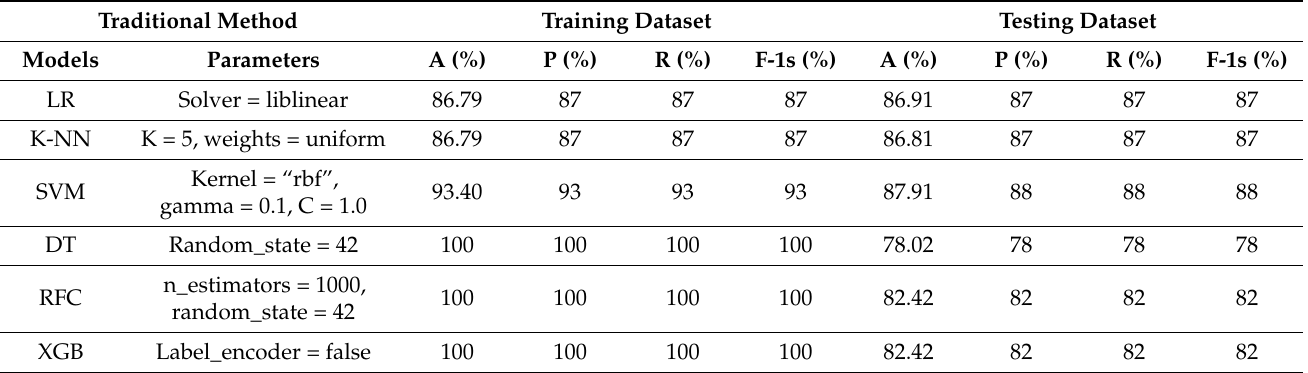
Table A1. For the training and test datasets, classification models were evaluated and compared.